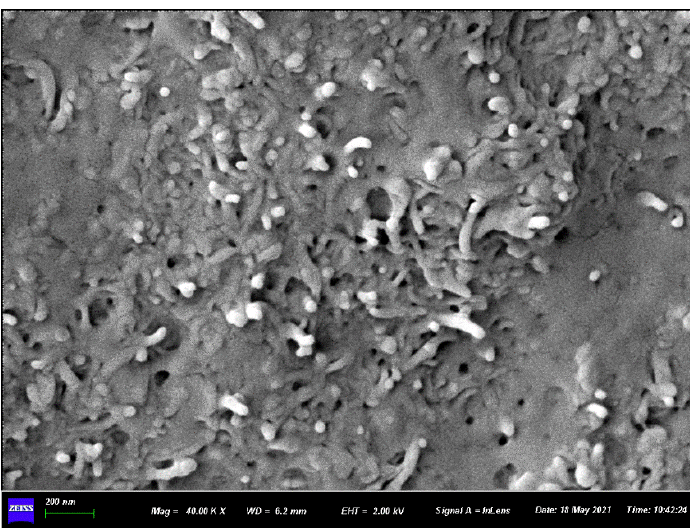
Figure 5. Impact profiles of 10 wt.% MWCNT/PA12 composite samples.